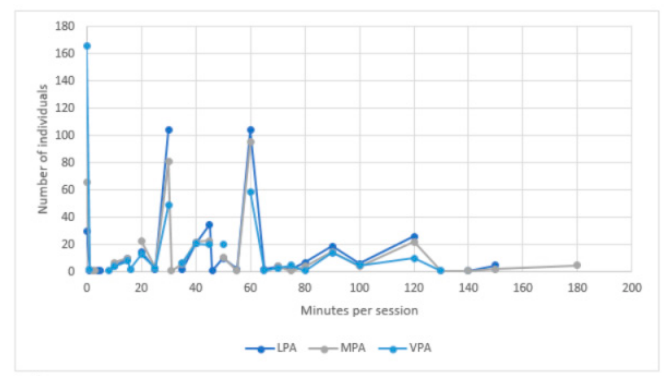
Figure 3. Overall level of physical activity per week (per physical intensity